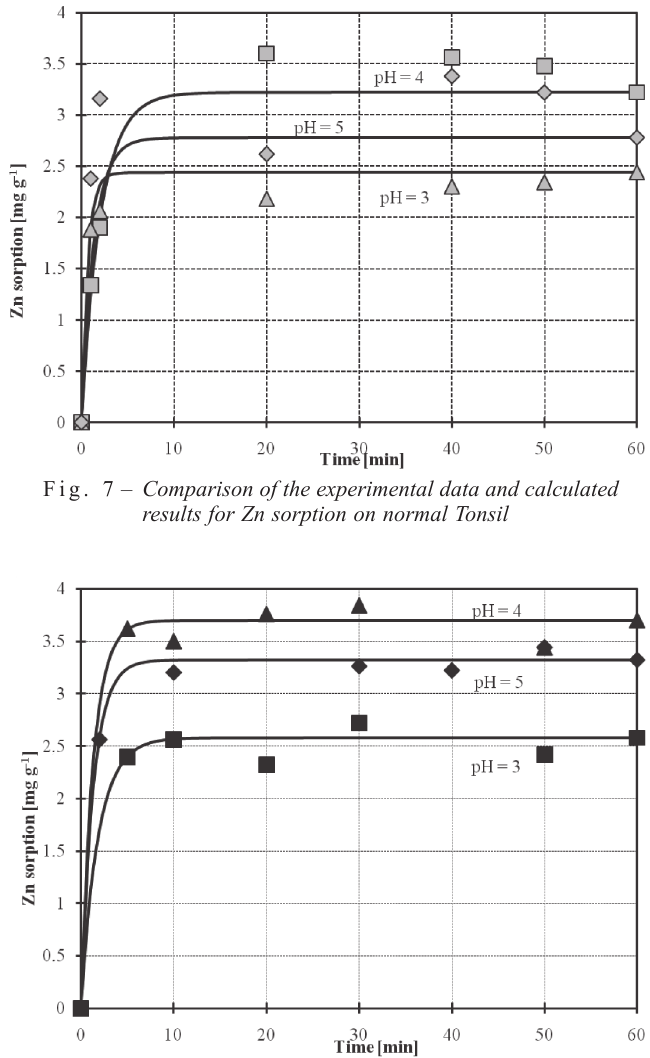
Fig. 8 – Comparison of the experimental data and calculated results for Zn sorption on ultrasonic-activated